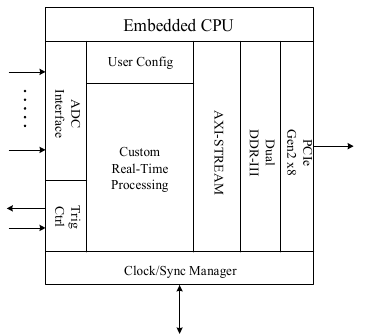
Figure 5. The internal structure diagram of Field-Programmable Gate Array (FPGA).